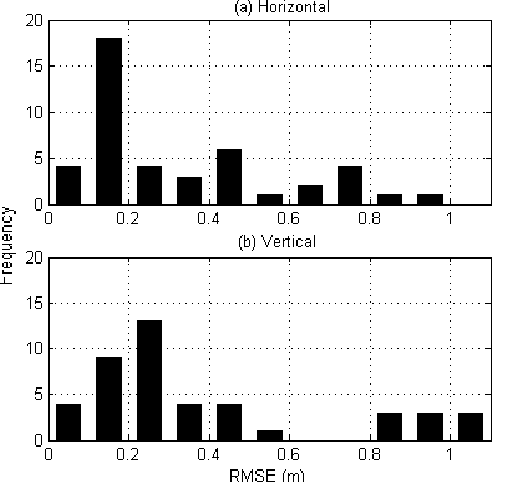
Figure 4. Relative frequency of positioning accuracies after convergence in the (a) horizontal and (b) vertical directions. A total of 44 test cases are included in the histogram.